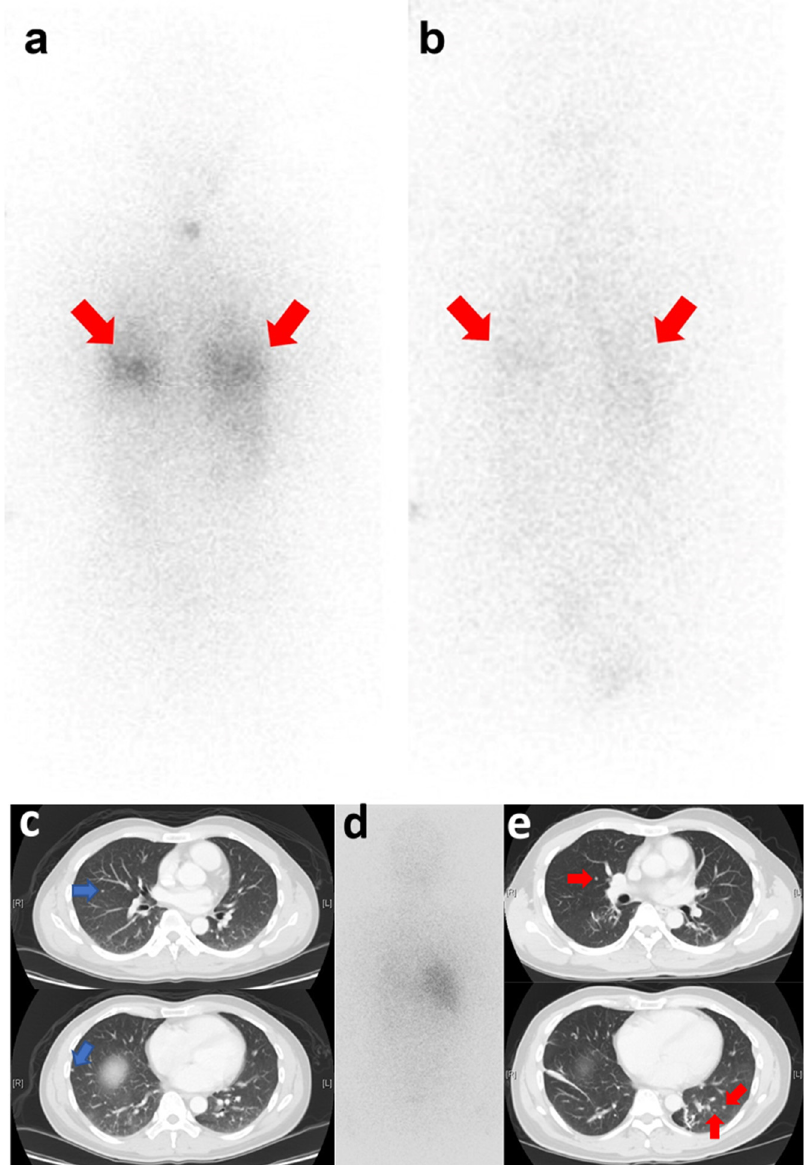
Figure 3. Posttreatment (100–150 mCi 131 I) whole-body scan (WBS) images (posterior view) obtained from two patients in group 1 ( a , b ) and group 4 ( c – e ). ( a ) A 30-year-old woman prepared using rhTSH stimulation. Bilateral lung metastases (red arrows) were initially identified in 2015. ( b ) Three years later and following six treatment courses, regression of metastases was observed (red arrows) along with reduced 131 I uptake. ( c , d ) A 34-year-old man prepared using THW. Right lung metastases were initially identified on computed tomography (CT) (blue arrows) in 2014, but no radioiodine avidity was evident on WBS images. ( e ) After three years and following three treatment courses, a CT scan revealed disease progression with bilateral lung metastases (red arrows).